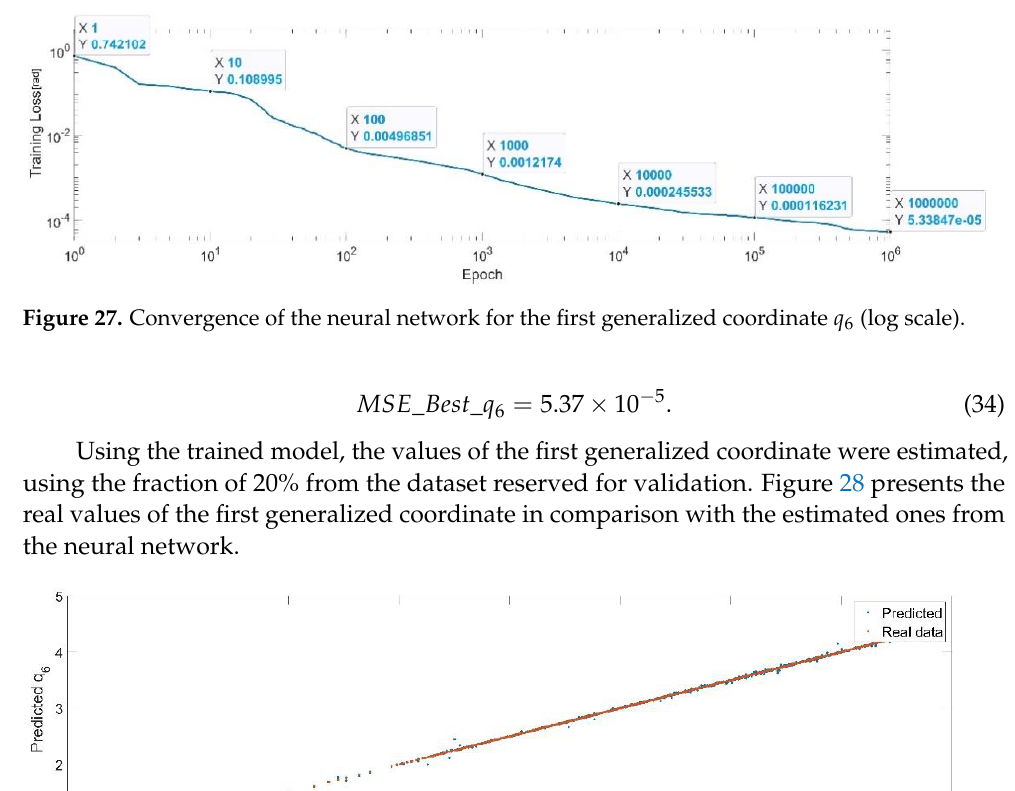
Figure 28. The comparison between the real data (the real value of 𝑞 6 ) and the predicted data (the predicted value of 𝑞 6 ).